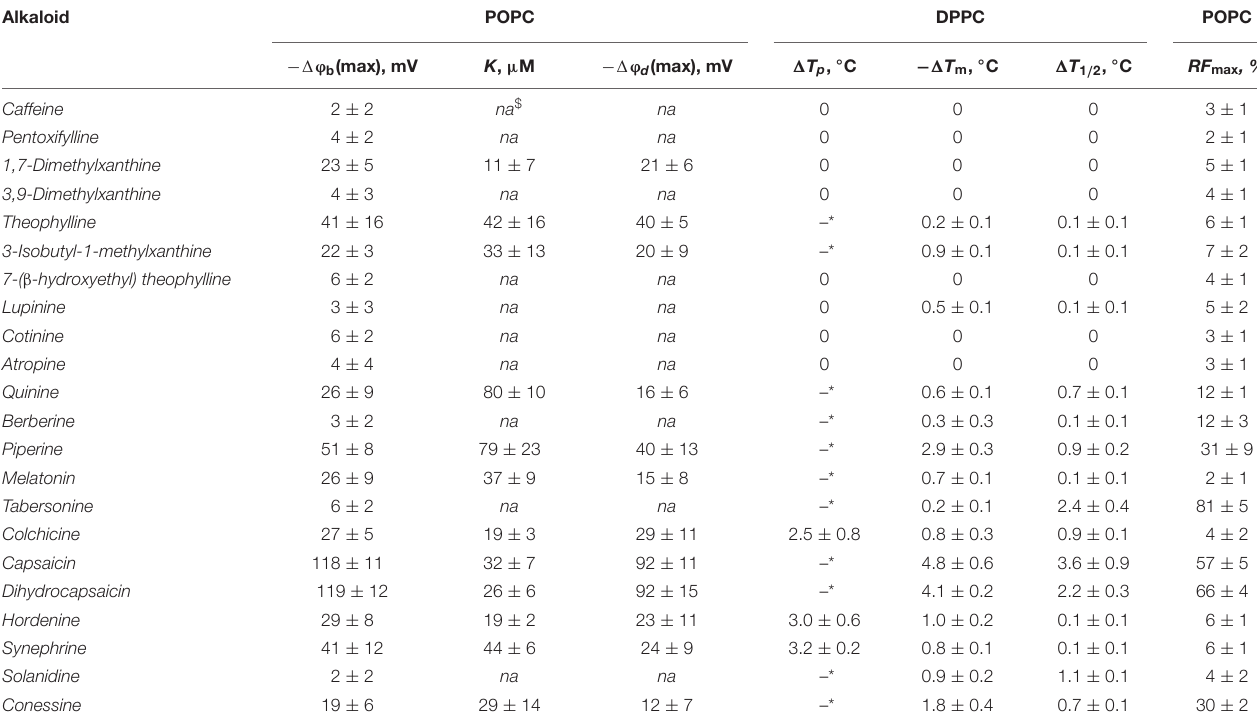
TABLE 1 | The parameters characterized the effects of alkaloids on the physical properties of lipid bilayers: (cid:49) ϕ b (max) – the maximum changes in the boundary potential of POPC-membranes, K – the desorption constant of alkaloid, (cid:49) ϕ d (max) – the maximum changes in the dipole potential of POPC-membranes; (cid:49) T p – the changes in the DPPC pre-transition temperature, (cid:49) T m – the changes in the main transition temperature; (cid:49) T 1 / 2 – the changes in the half-width of the main peak at a lipid:alkaloid molar ratio of 10:1; RF max – maximal leakage of calcein from unilamellar POPC vesicles. Alkaloid POPC